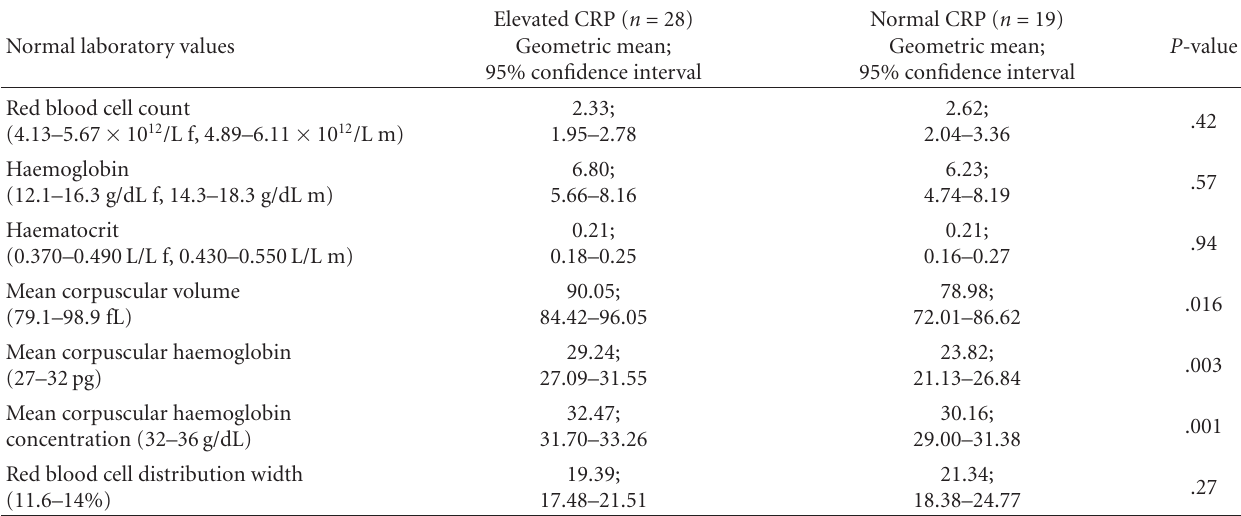
Table 4: Red blood cell indices for patients with elevated C-reactive protein and patients with normal C-reactive protein. Normal laboratory values